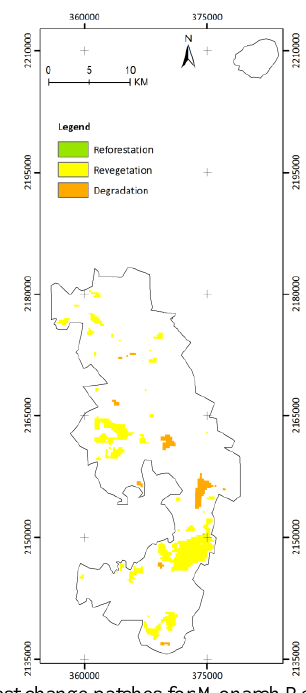
Figure 3. Forest change patches for Monarch Reserve